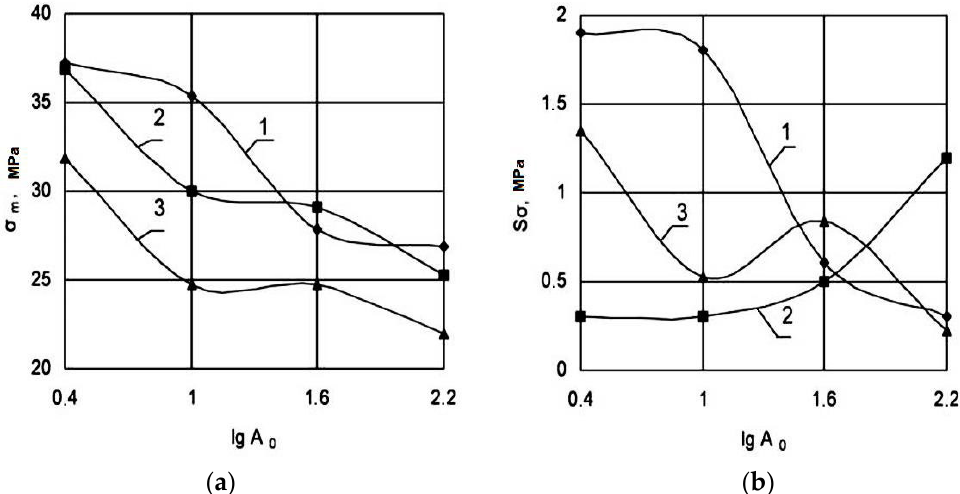
Figure 2. Dependence of ( a ) the average value of the yield strength and ( b ) the standard deviation of the yield strength on the logarithm of the cross-sectional area of the samples A 0 . Thermoplastics are based on polypropylene: (1) PP 21060-16, colorless; (2) PP 21060-A20; (3) MPP 15-04 colorless. The dispersion of the values of equivalent stresses is affected by the dispersion of elastic, deformation, and thermophysical characteristics (Table